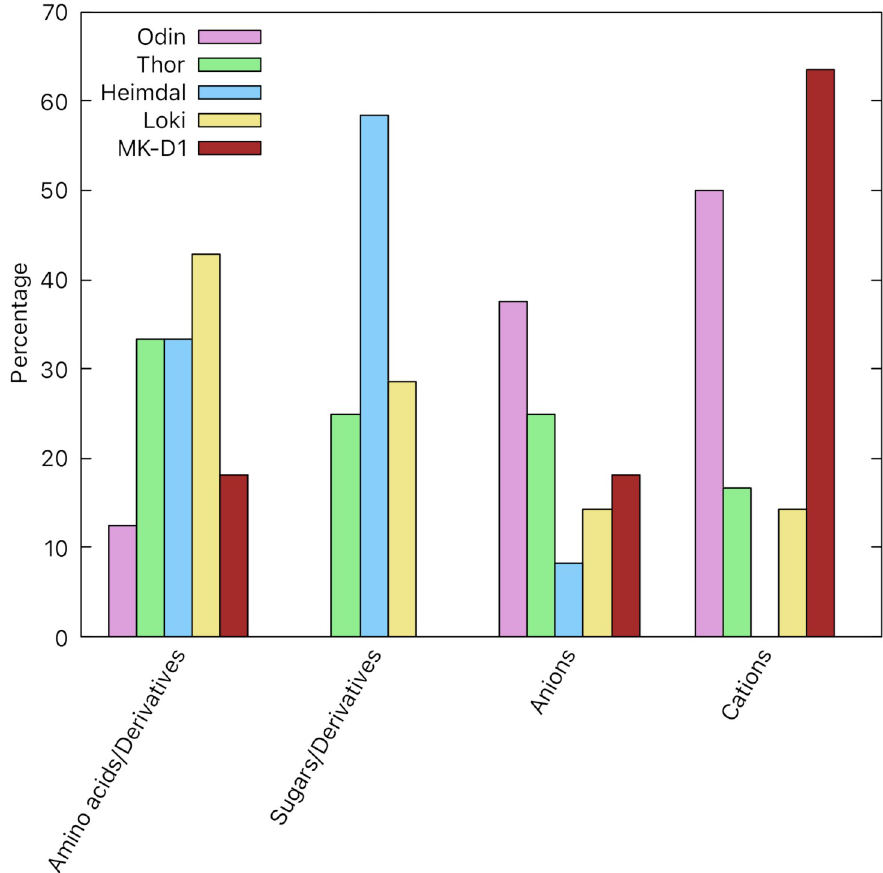
Fig 4. Substrates imported by ABC systems encoded within the five Asgard transportomes. The percentage of each substrate type was calculated relative to the total number of substrates transported by ABC uptake systems per Asgard